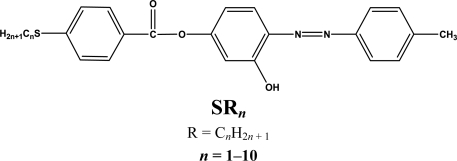
Structures of the studied compounds SR1–SR10).